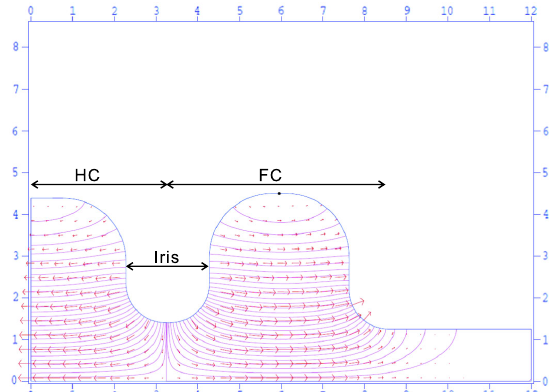
FIG. 3 (color online). Evolution of γ in the rf gun for the cases of ϕ 0 , (cid:2) 2 . 5 °, and (cid:2) 5 °.